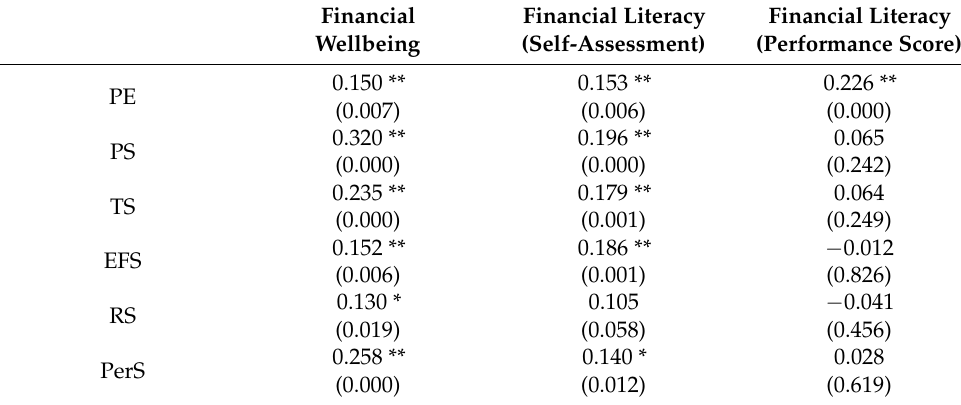
Table A1. Spearman’s rho correlations of financial wellbeing and financial literacy (as measured via Self-Assesment and Performance Score) on initial forecasts and percentage changes in forecasts (post-scenario).